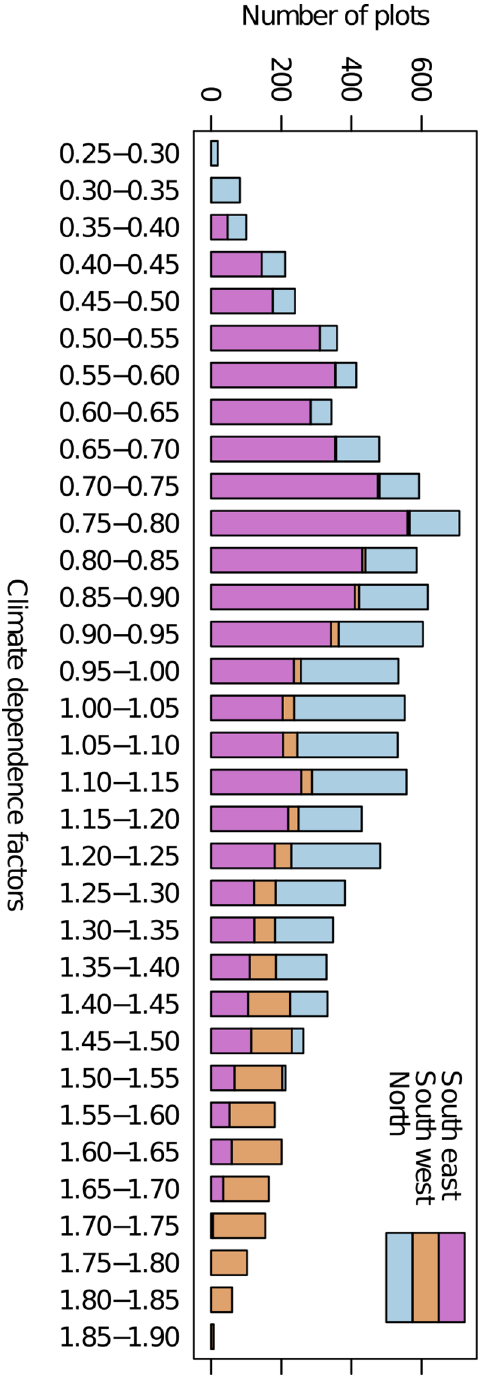
Fig 6. Frequency distribution of Yasso07 climate dependence factors. Dependence factors were generated for each NFI plot using constant climate (long-term mean 1991 – 2008), and colors show their distribution to three regions (regions are shown in Fig 1). The dependence factors were generally highest in the southwest and lowest in the